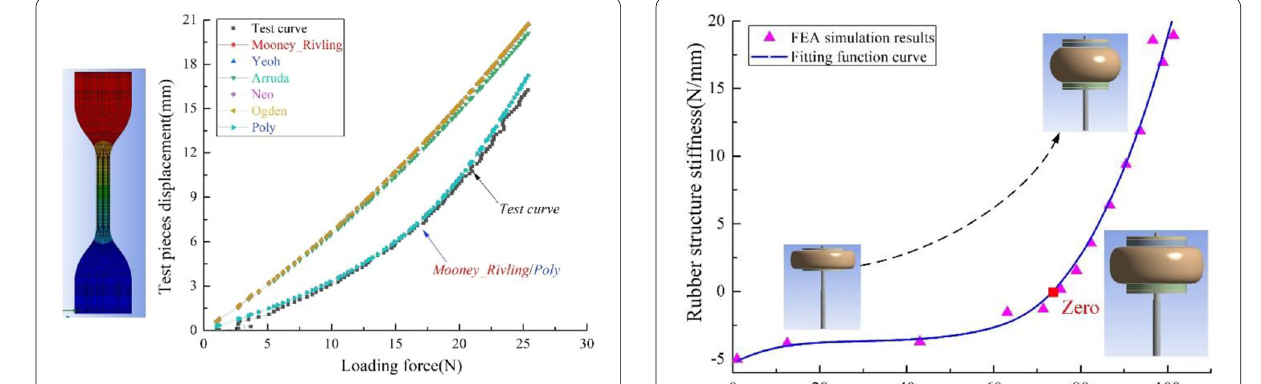
Figure 5 The test pieces displacement curve of FEA simulation results and test result Table 1 Parameters of rubber Mooney-Rivlin model Rubber parameter